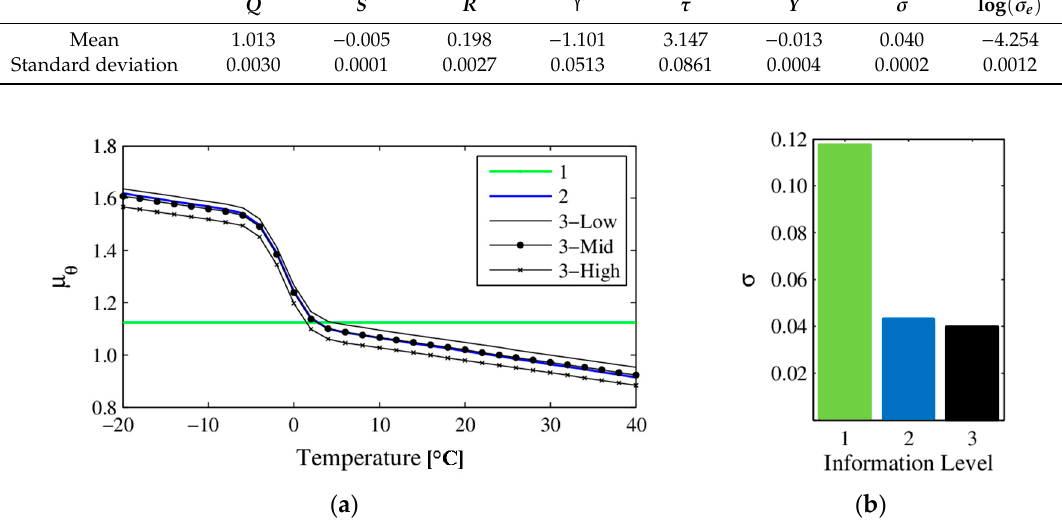
Figure 5. Estimated stiffness mean ( a ) and variance (shown as CoV) ( b ) at information levels 1, 2 and 3 [54].